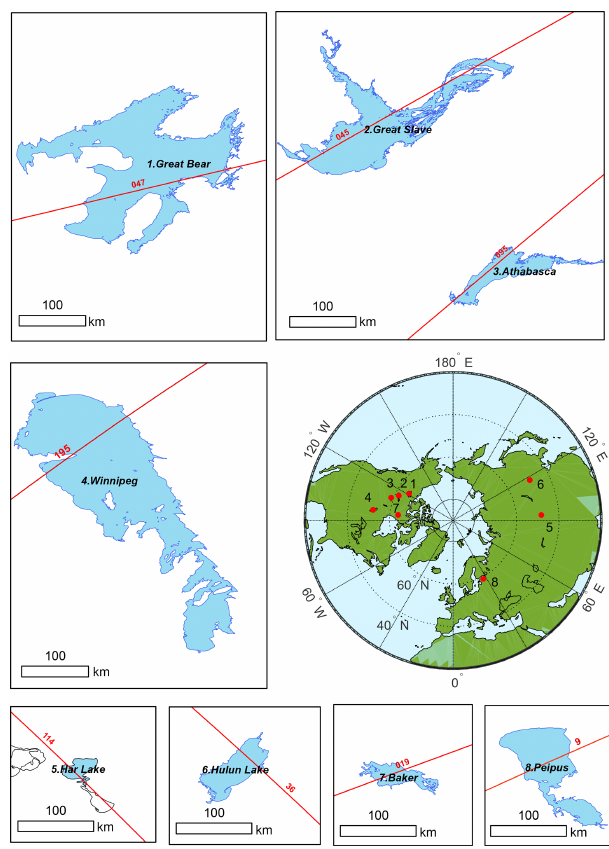
Figure 1. Study lakes and satellite altimetry ground tracks used. Red curves denote ground tracks of T/P and Jason-1/2/3. Red num- bers denote the ground track